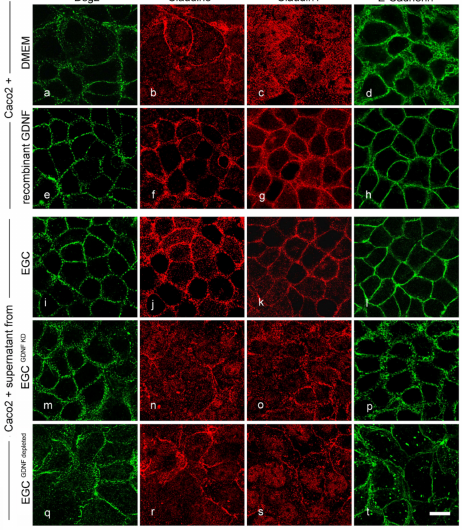
Figure 5. Enteric glial cells (EGC)-mediated effects on junctional proteins are glial cell line-derived neurotrophic factor (GDNF) dependent. Representative immunostainings under various conditions are shown. In immature Caco2 cells junctional proteins distribution of desmosomal Desmoglein2 (Dsg2) ( a ) and tight junction proteins Claudin5 ( b ), Claudin1 ( c ) and adherens protein E-Cadherin ( d ) were not regularly located at the cell borders. Application of recombinant GDNF augmented linear staining of all junctional proteins at the cell borders ( e – h ). Similar effects were observed following incubation with supernatants from EGCs ( i – l ). These effects of EGC on enterocytes were absent when cells were incubated with supernatants from EGC GDNF KD ( m – p ) and with EGC supernatant in which GNDF had been depleted ( q – t ); (representatives are shown for n = 6, Scale 20 µ m).